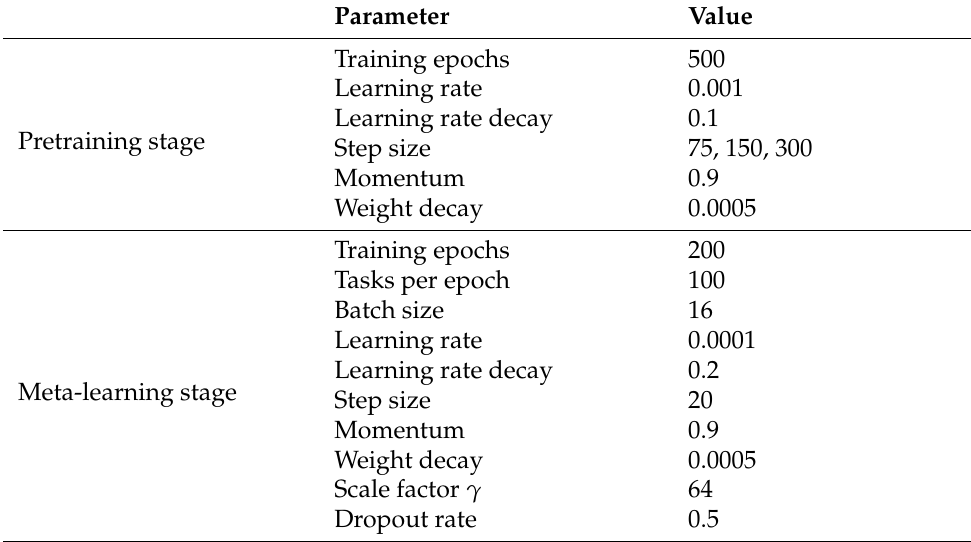
Table 3. Optimization related